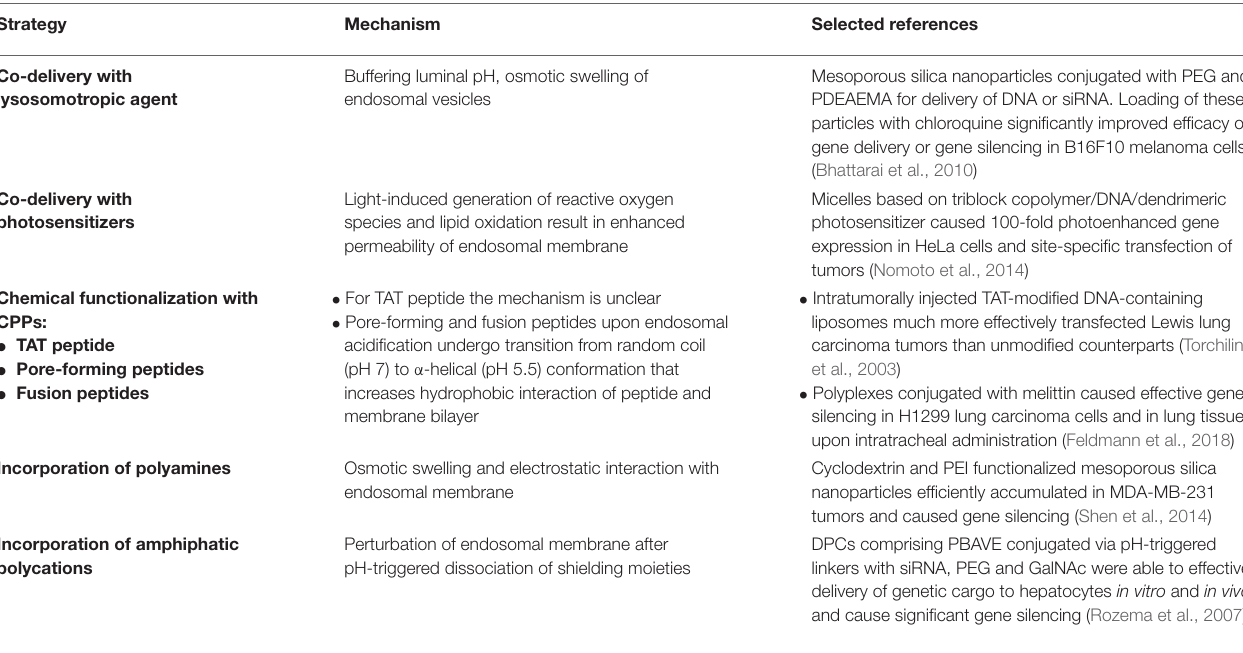
TABLE 1 | Main strategies to facilitate endosomal escape of nucleic acid